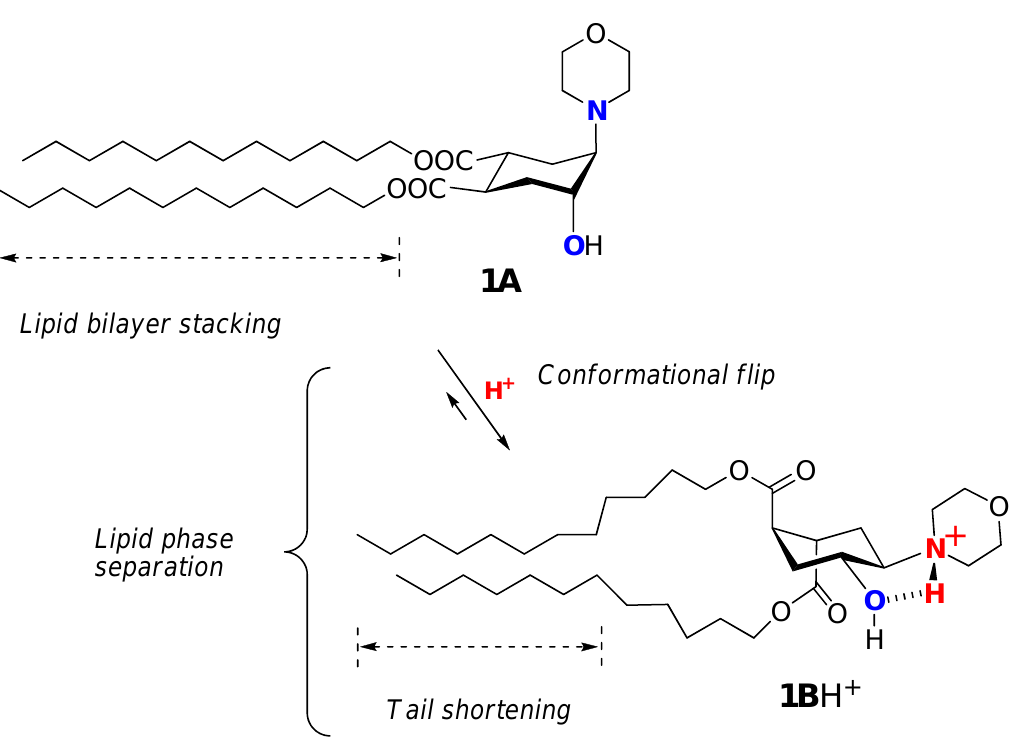
Figure 9. Protonation-induced conformational shortening of flipid 1 causes a quick perturbation of the lipid bilayer, lipid phase separation, and a fast fliposome